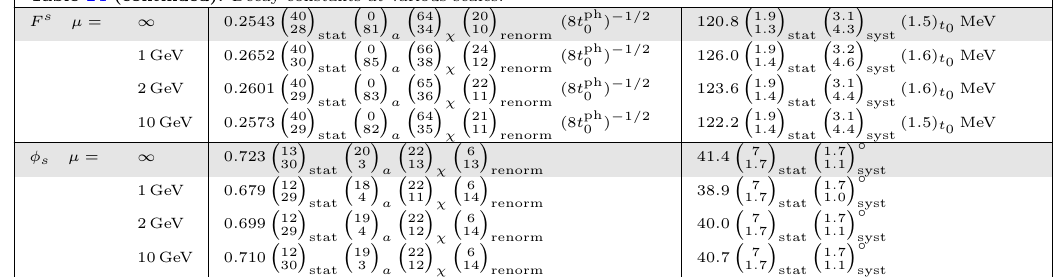
Table 24 (continued): Decay constants at various scales.